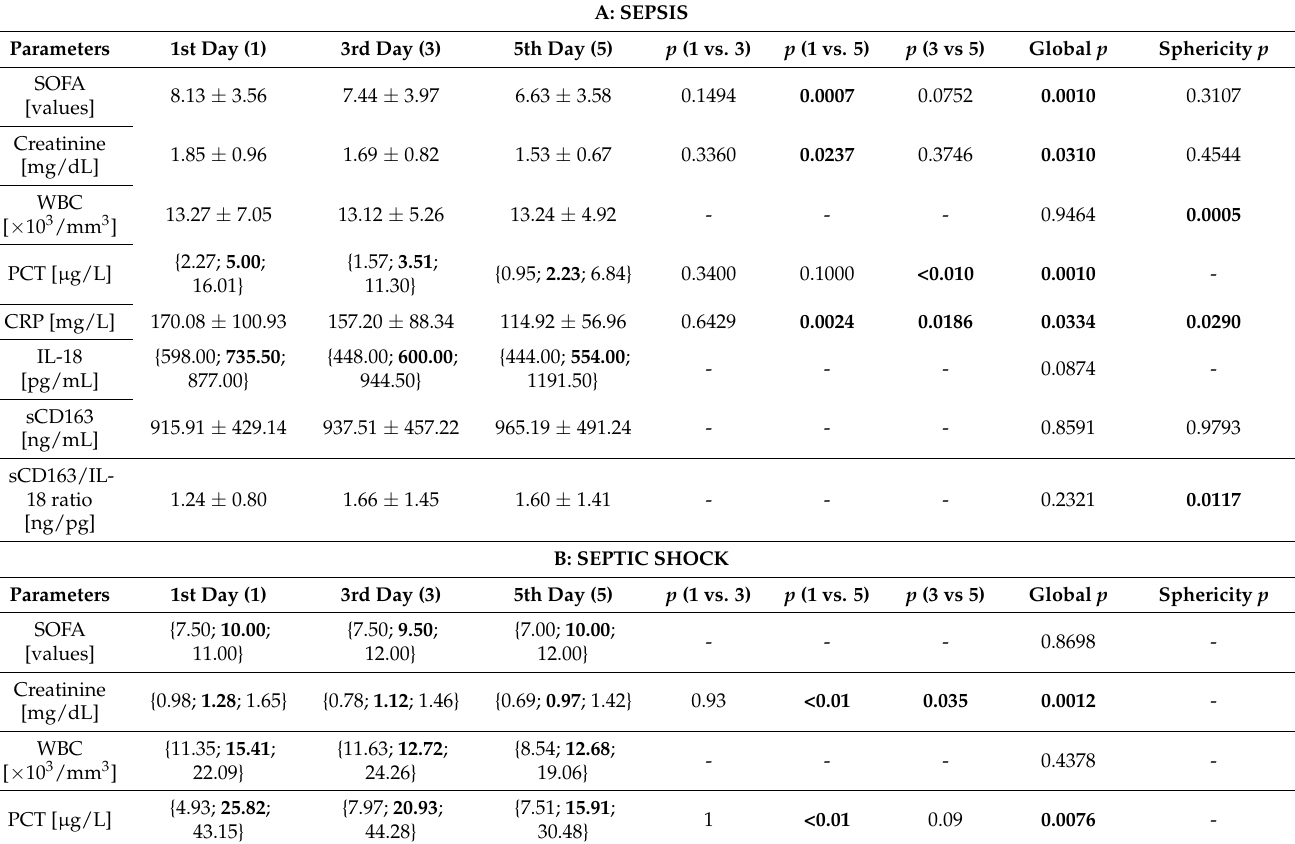
Table 3. Time-related changes in values of selected parameters in patients with sepsis and septic shock. A: